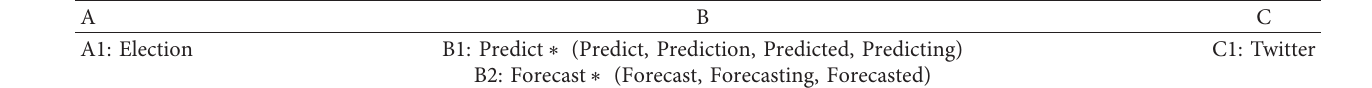
Table 2: Definition of keywords.